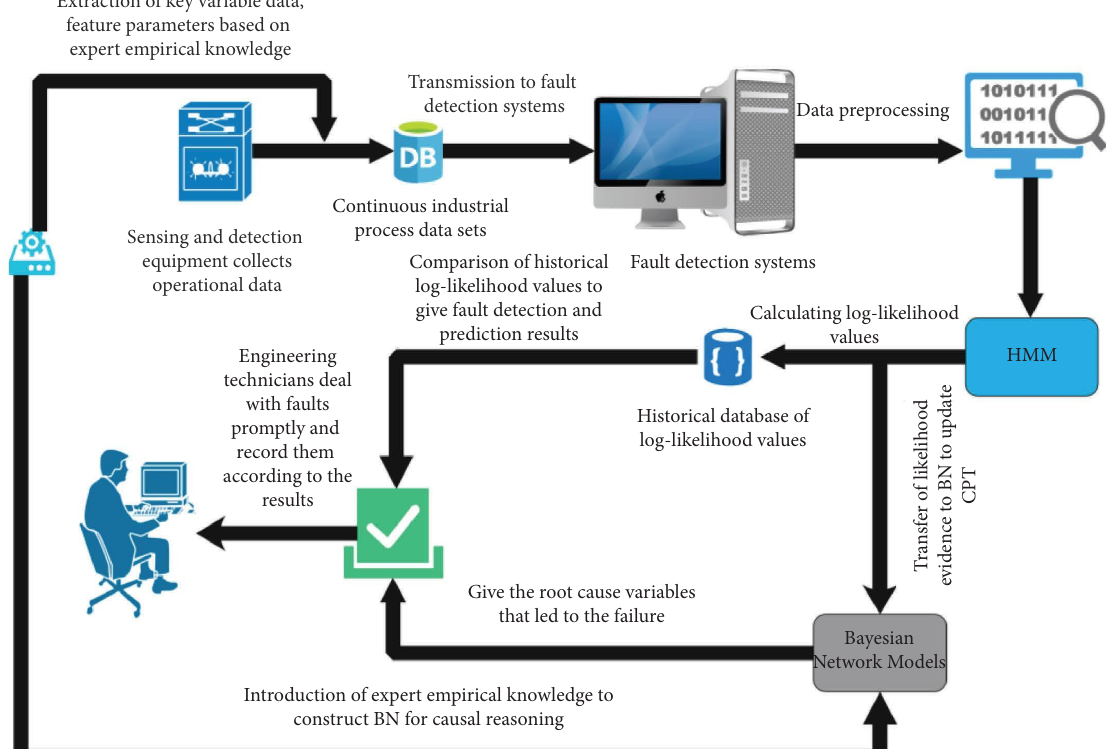
Figure 6: HMM-BN modeling schematic.